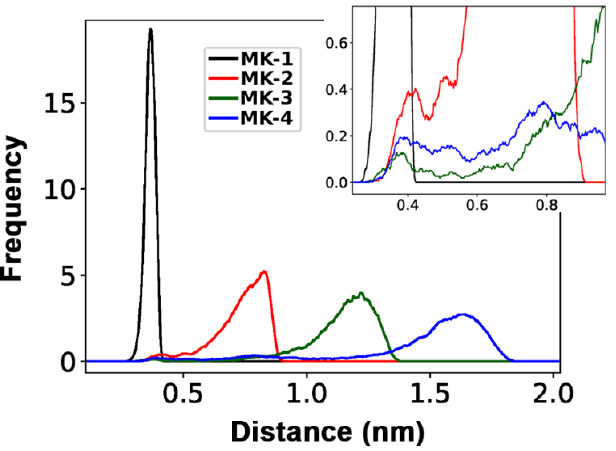
Figure 12. Distance distribution from terminal carbon (CT) to the center of the MK quinone head- group, d(CT-H) in MK-1 (black), MK-2 (red), MK-3 (green), and MK-4 (blue). The upper right panel is a zoom-in of the distance range 0.3–1.0 nm (3–10 Å).